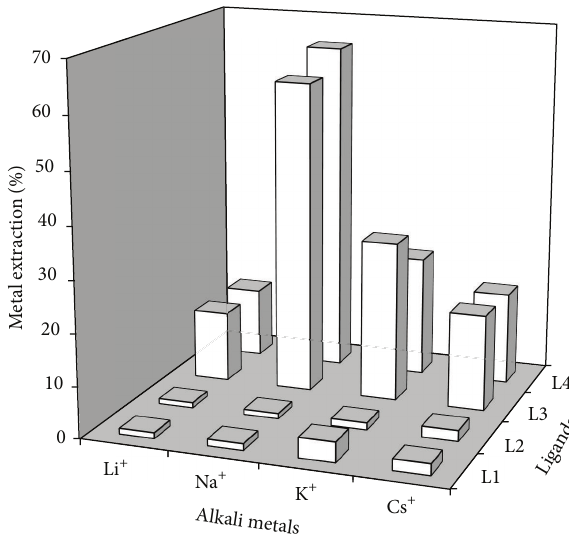
Figure 8: Extraction of alkali metal cations with